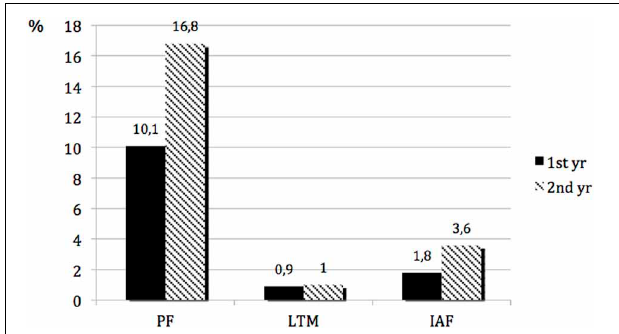
FIGURE 7 | Relative frequency of single codes relativized by the average number of